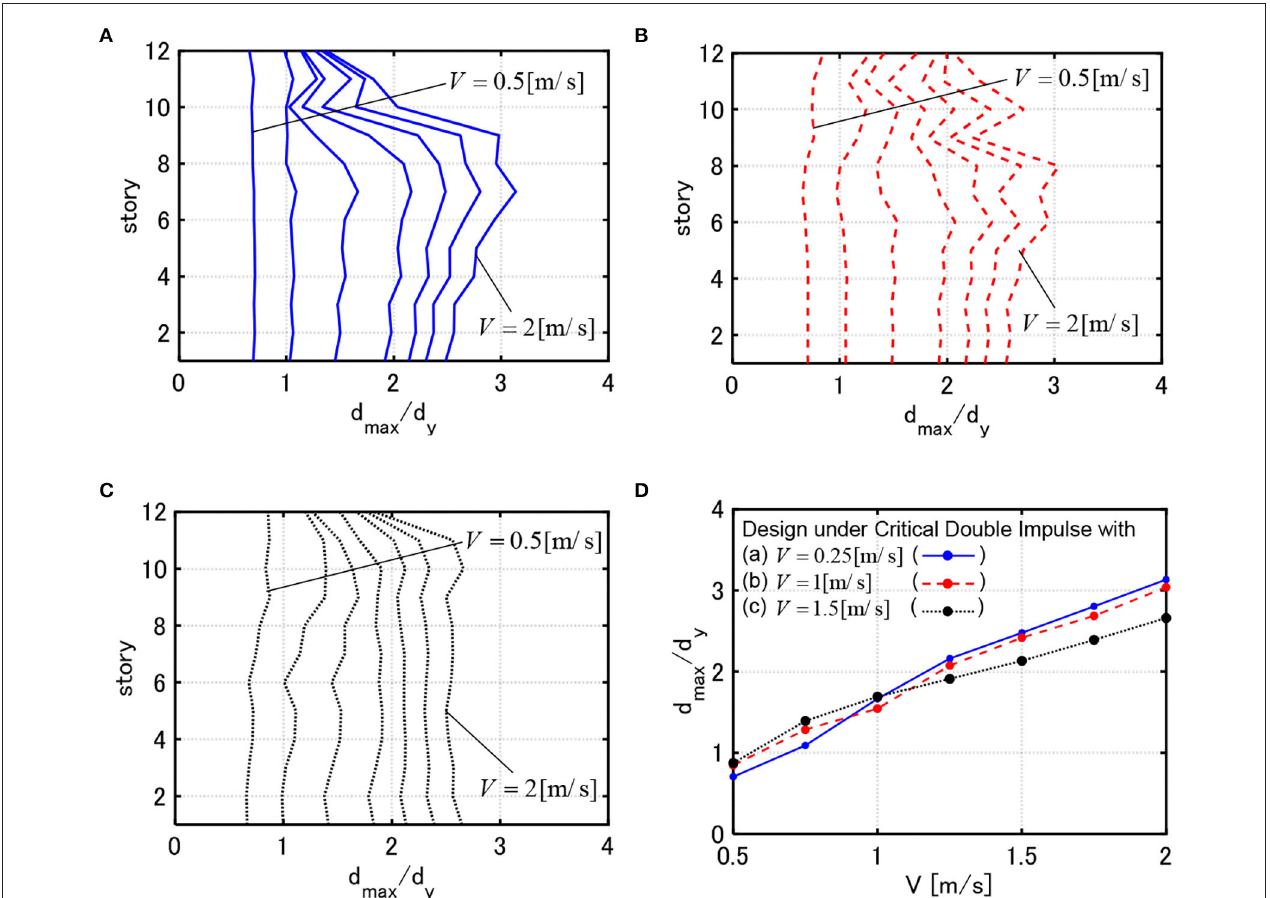
FIGURE 9 | DIP analysis for 3 models with W cF = 20 × 10 7 [ Ns / m ]. (A) Response of model designed under critical double impulse with V = 0.25[ m / s ]. (B) Response of model designed under critical double impulse with V = 1.0[ m / s ]. (C) Response of model designed under critical double impulse with V = 1.5[ m / s ]. (D) Comparison of maximum deformations for 3